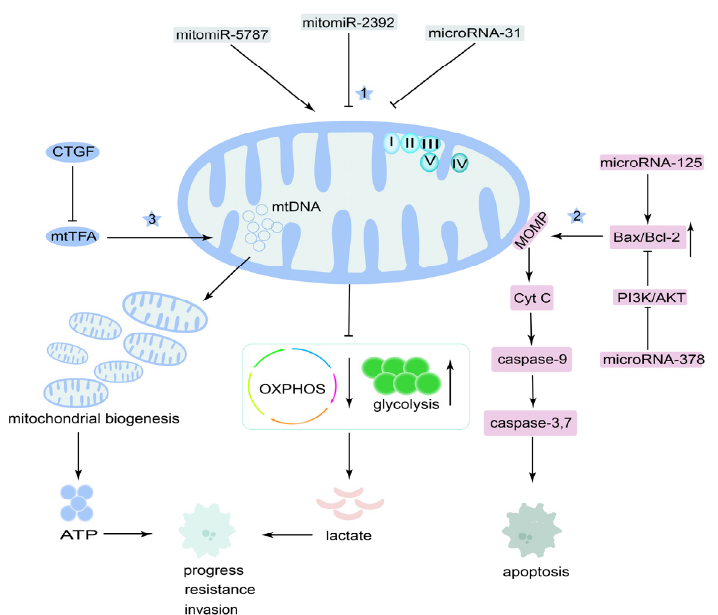
Figure 6. Mechanism of mitochondrial microRNA (mitomiRs) and mitochondrial DNA (mtDNA) in OSCC therapy and resistance. (1) Reducing oxidative phosphorylation (OXPHOS) and upregulating glycolysis via mitomiRs or microRNAs can induce lactate production, which causes resistance and invasion. (2) Regulating microRNAs can cause mitochondrial apoptosis pathways. (3) Upregulated mtDNA content can promote cancer progression.